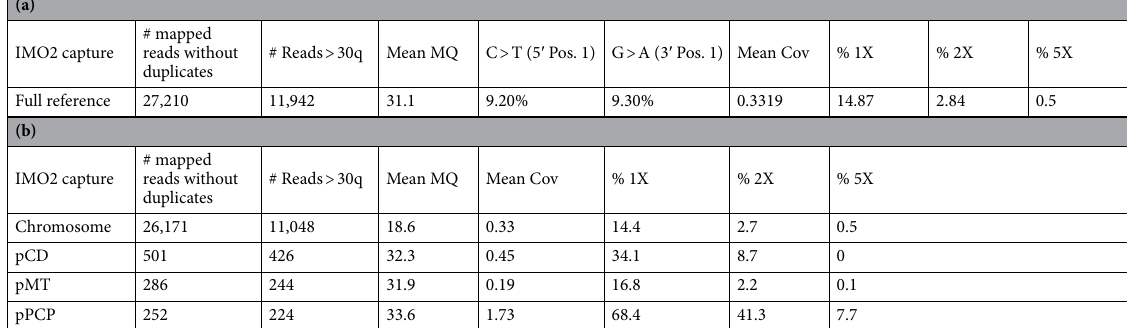
Table 5. Mapping Statistics for alignments of sequencing data from enriched libraries to the Y. pestis CO92 reference genome (-n 0.01; MQ > 0). (a) Statistics for whole reference sequence and (b) statistics for each chromosome and plasmid separately.